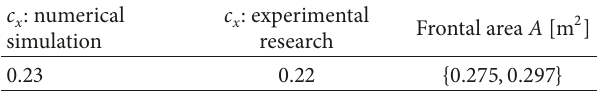
Table 2: The air drag coefficient and frontal